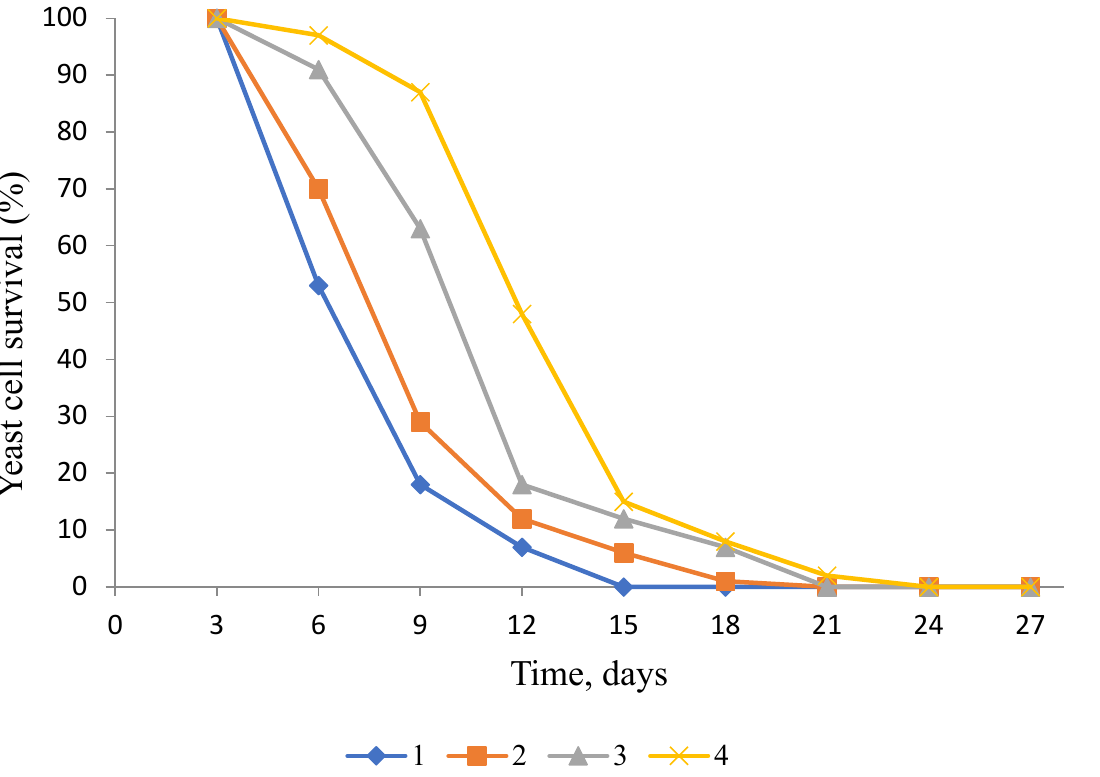
Figure 6. Chronological lifespan of Saccharomyces cerevisiae Y-564 with and without Amelanchier ovalis berry extract: 0.25, 0.5, and 1.0 mg/mL: 1—untreated with Amelanchier ovalis extract; 2—treated with Amelanchier ovalis (0.25 mg/mL); 3—treated with Amelanchier ovalis (0.5 mg/mL); 4—treated with Amelanchier ovalis (1.0 mg/mL).